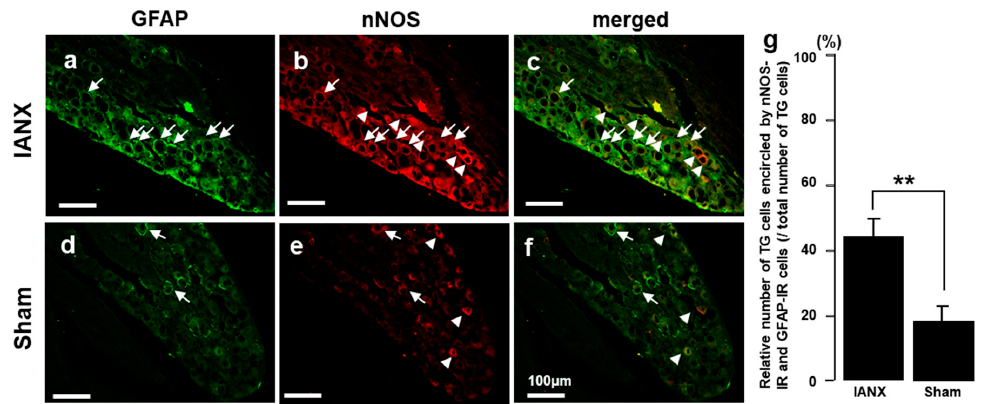
Figure 6. nNOS expression in GFAP-IR cells after IANX or sham surgery. ( a – f ): Photomicrographs of GFAP-IR cells and nNOS-IR cells in III branch region of TG in IANX and sham rats. ( g ): Relative number of GFAP-IR cells and nNOS-IR cells in III branch region of TG in IANX and sham rats. The arrows indicate GFAP-IR+ nNOS-IR cells, and arrowheads indicate nNOS-IR cells. ** p < 0.01. n = 5 in each group.